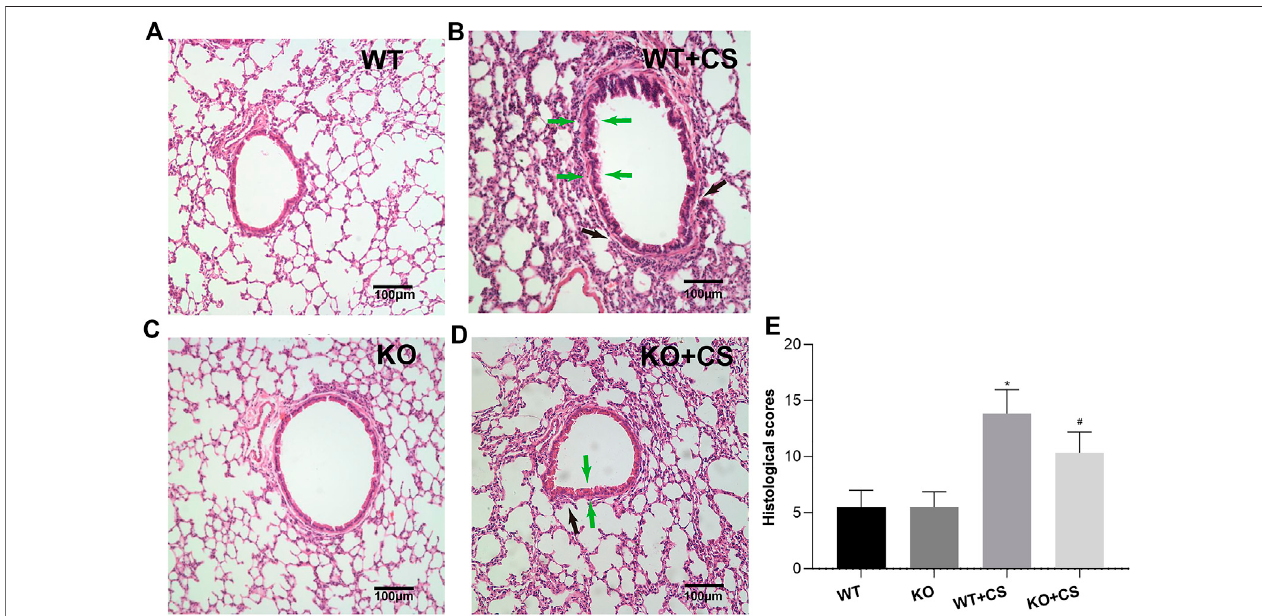
FIGURE 1 | FPR-1 KO reduces CS-induced histological changes in mouse lungs. Representative photomicrographs of HE stained sections of lung tissues from eachgroupwereshown. (A) WTgroup, (B) WT+CSgroup, (C) KOgroup, (D) KO+CSgroup,and (E) Histologicalscores.Blackarrow:peribronchialin fl ammatorycells; greenarrow:airwayepitheliumthickening.* p < 0.05vs.WTgroup,# p < 0.05vs.WT+CSgroup. n (cid:1) 6ineachgroup.Abbreviations:CS,cigarettesmoke;WT,wildtype; KO, knockout.